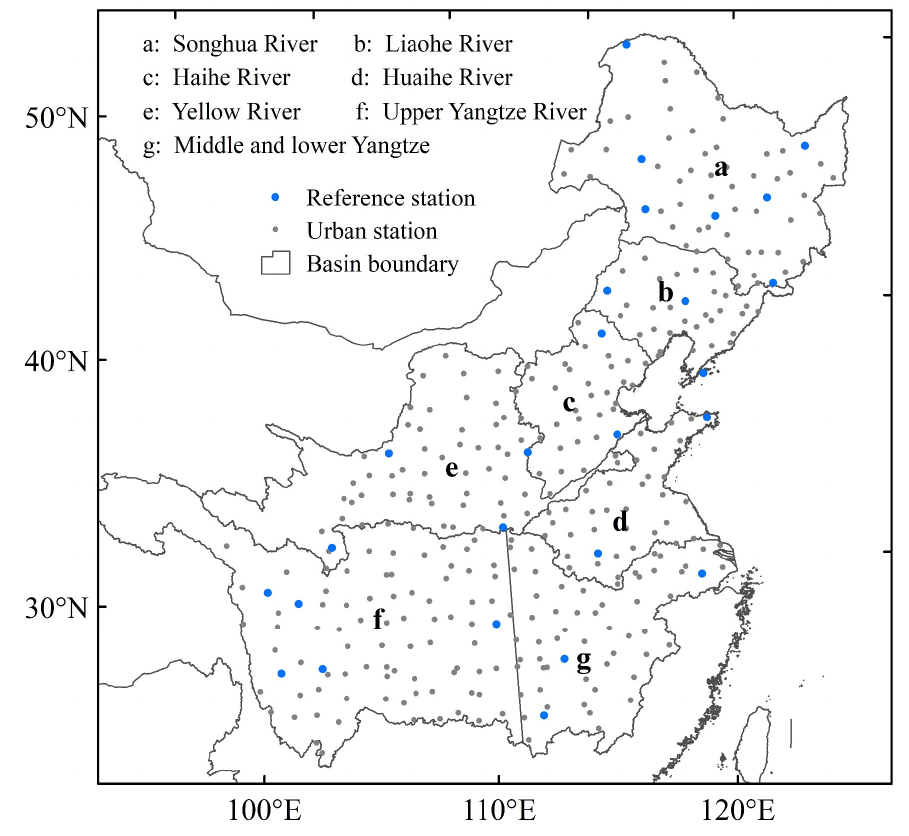
Figure 1. The distribution of the reference and urban stations in each river basin.